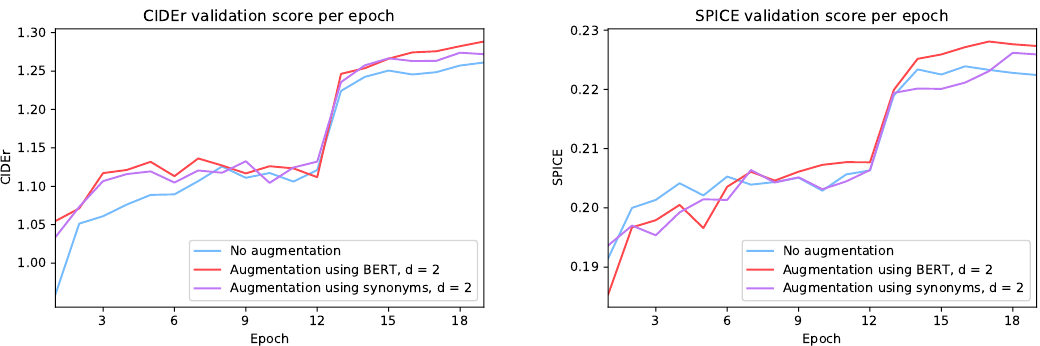
Figure 2. Validation scores per epochs during a training phase on a dataset without augmentation, on a dataset with BERT augmentation with d = 2 and on a dataset with synonyms augmentation with d =